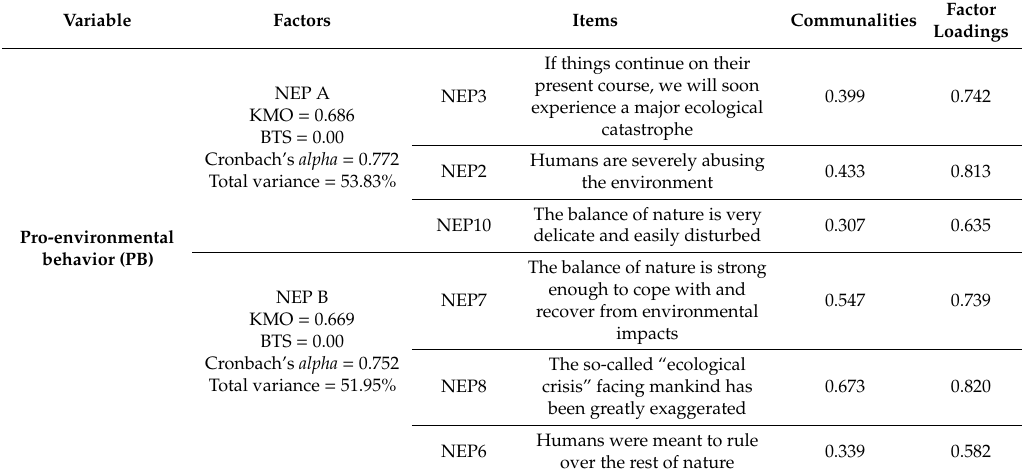
Table A3. Factor loading and communalities for pro-environmental behaviour